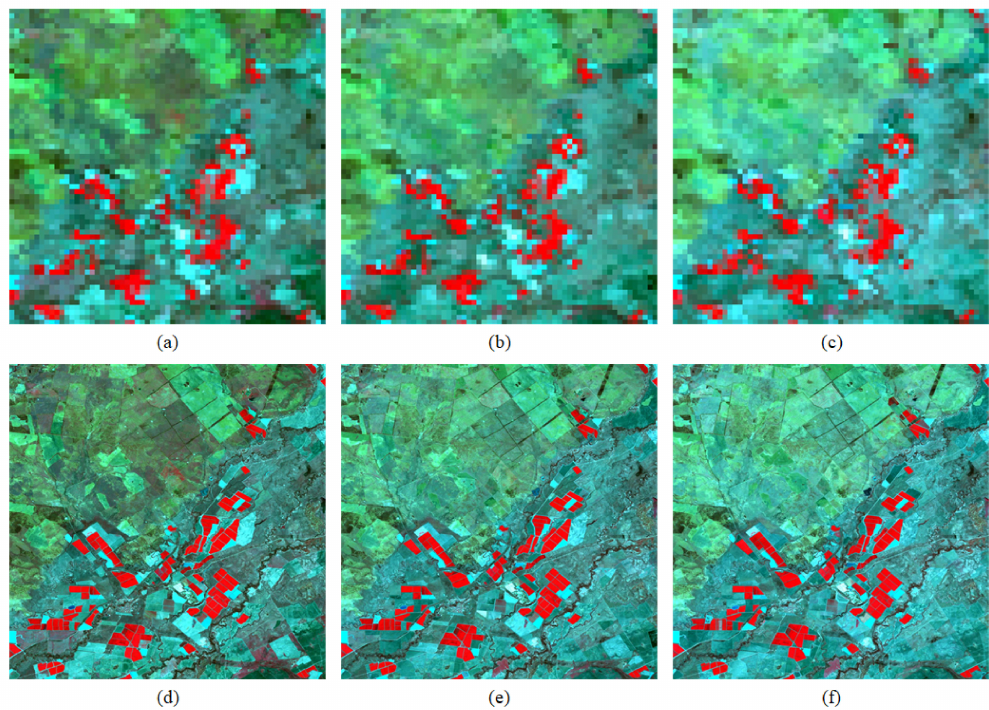
Figure 5. Composite MODIS (top row) and Landsat (bottom row) image pairs on 29 January ( a , d ), 14 February ( b , e ), and 2 March ( c , f ) 2005 from the LGC [31] dataset. The LGC dataset mainly contains changes in land cover types after the flood.